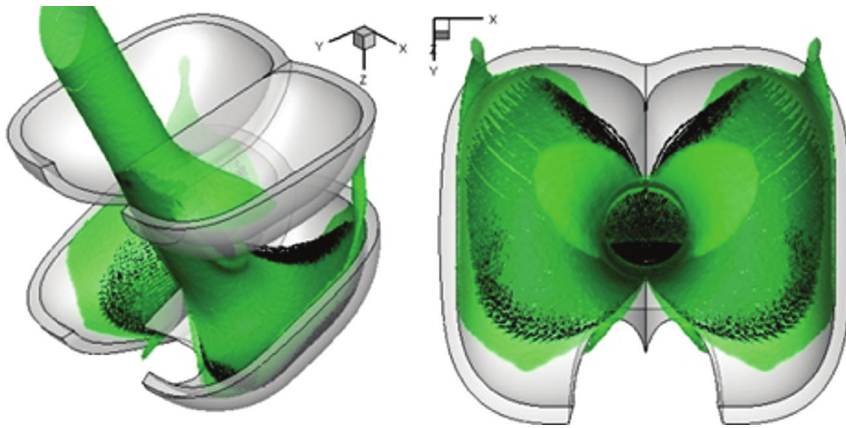
Figure 14: Water phase comparison of FLS (black lines) and Fluent (green areas) simulations.